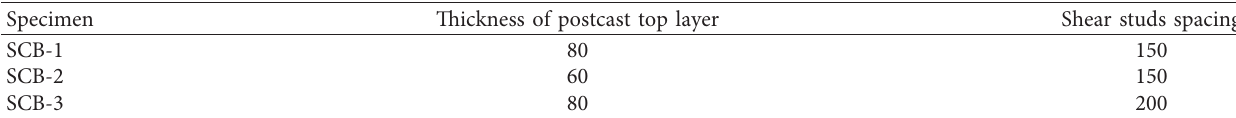
Table 1: Varied parameters of tested specimens (unit: mm).